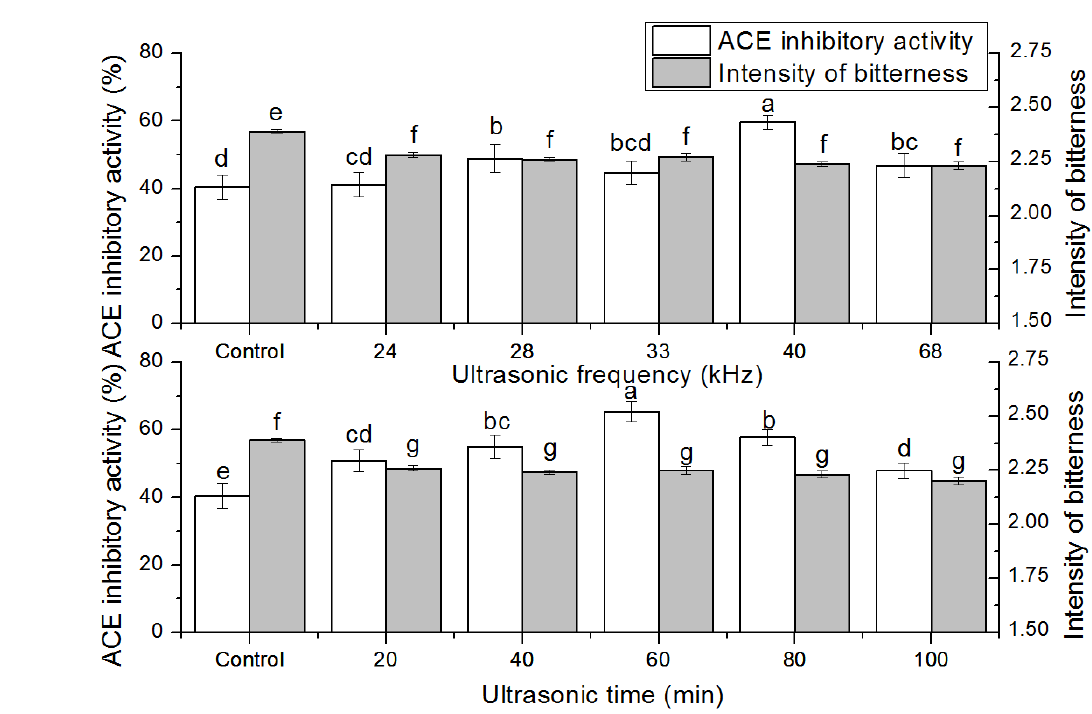
Figure 5. ( a ) The effect of ultrasonic frequency on the ACE inhibitory activity and bitterness of CGMHs under optimal multi-enzymatic hydrolysis parameters; ( b ) The effect of ultrasonic time on the ACE inhibitory activity and bitterness of CGMHs under optimal multi-enzymatic hydrolysis parameters. Significant differences between results are indicated by different letters ( p <